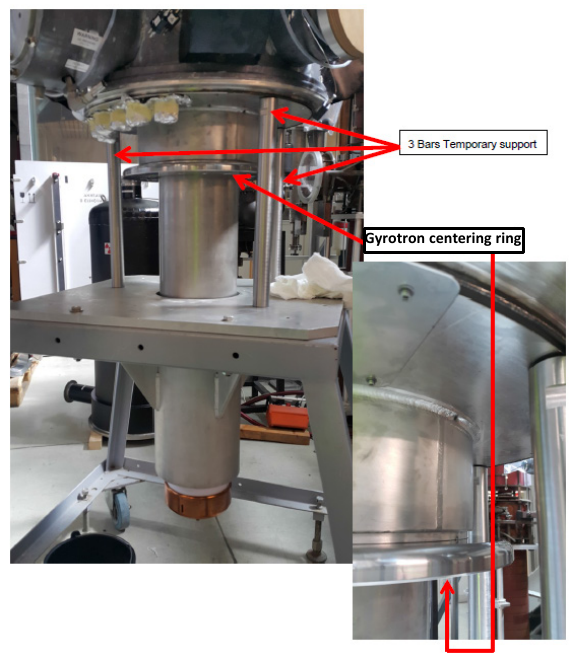
Fig. 10. EU gyrotron prototype (TH1509) at the KIT test stand.